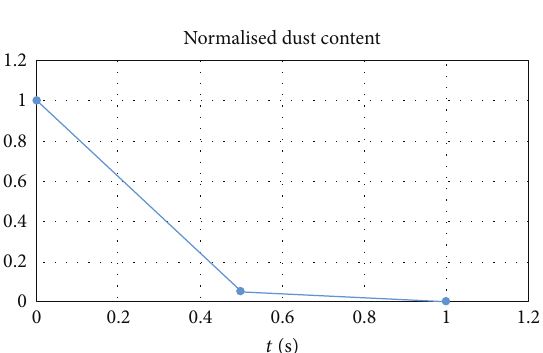
Normalised dust content